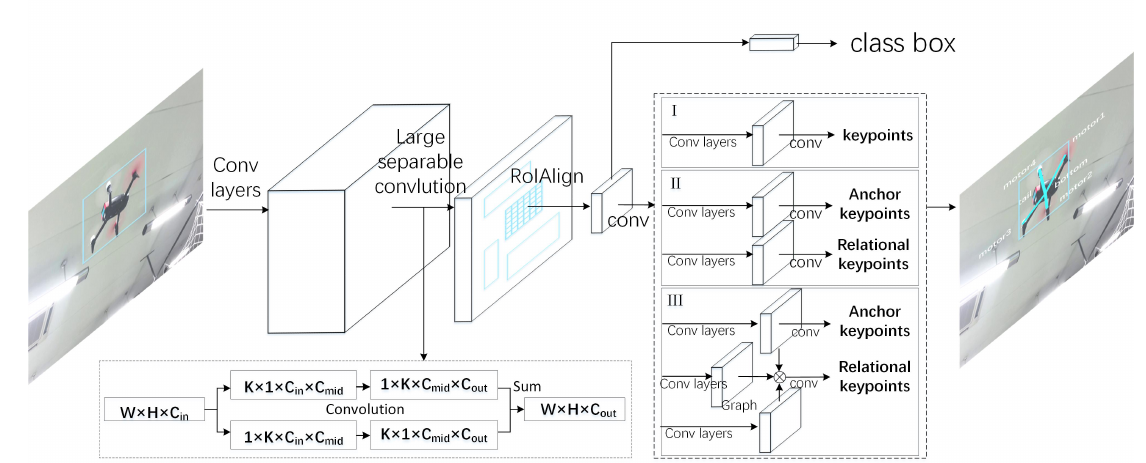
Figure 2. The quadrotor and its keypoints detection framework. We validate three kinds of keypoints heads; see the text description for the